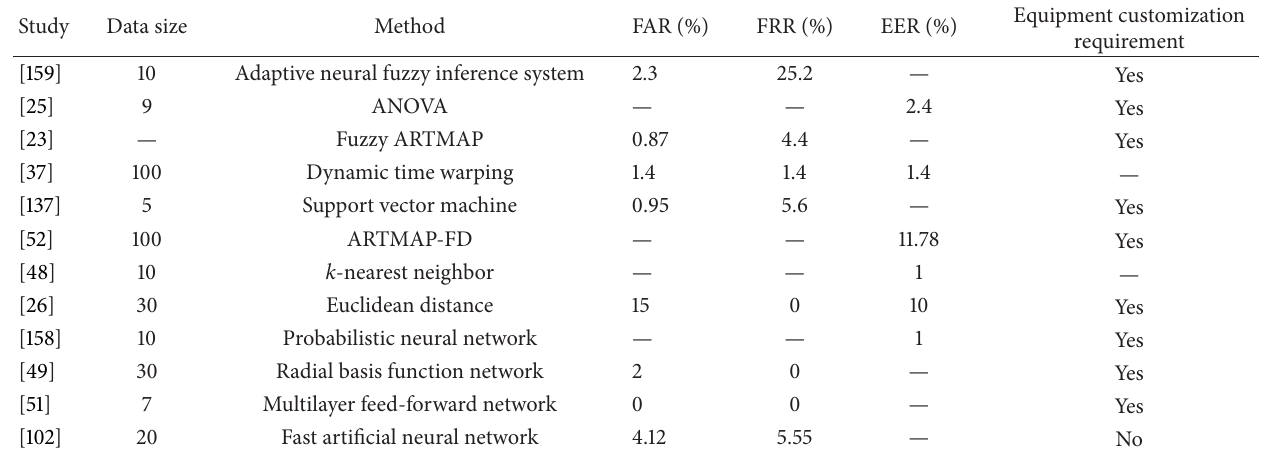
Table 7: Comparison between research works involving keystroke pressure